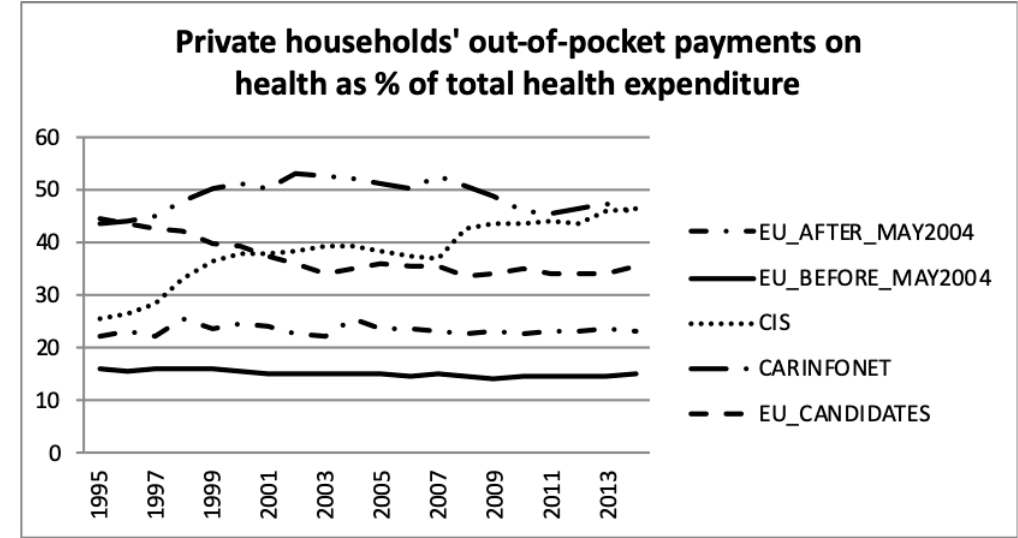
Figure 9. Private households’ out-of-pocket payments on health as a percentage of total health expenditure, the World Health Organisation